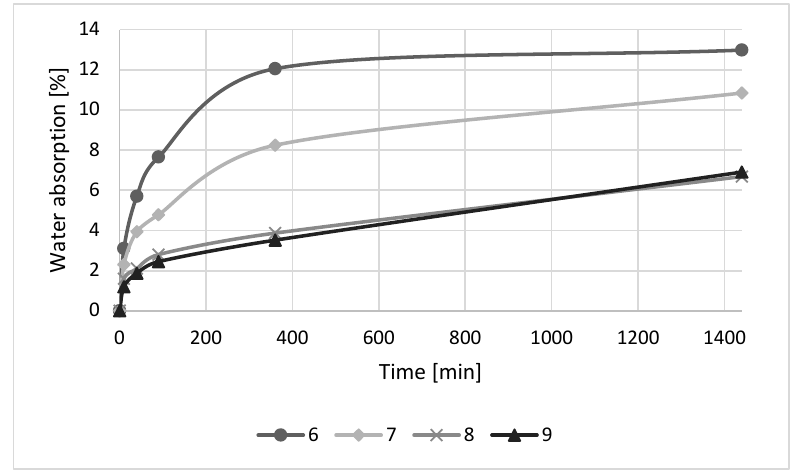
Figure 4. Water absorption results with different Na 2 O amounts in the alkaline activator.